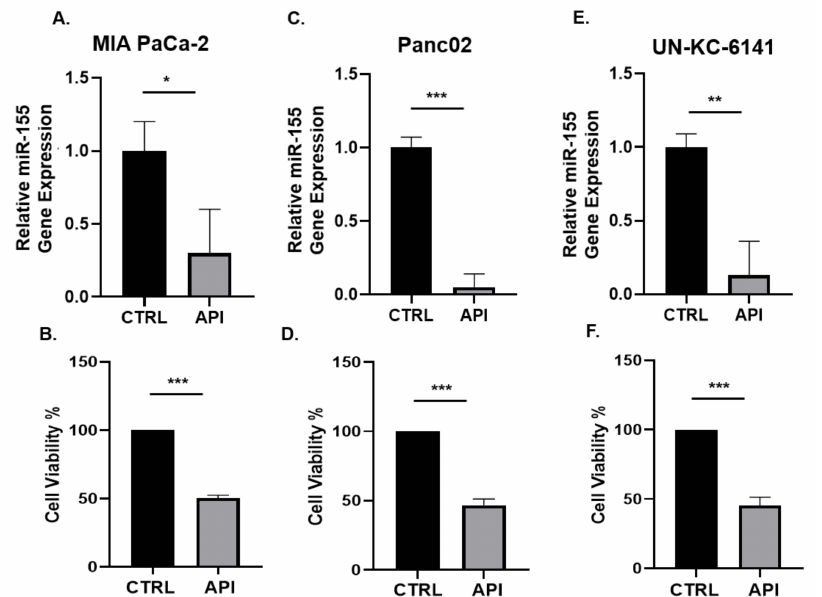
Figure 1. API suppressed miR-155 gene expression and inhibited cell viability in PC cells in vitro. The indicated human and mouse PC cell lines were treated with API (40 µ M) or vehicle (CTRL) for 24 h and assessed for ( A , C , E ) miR-155 gene expression by qPCR or ( B , D , F ) cell viability by MTT assay. Data presented as the mean ± S.D. of each experimental group ( n = 3). * p < 0.05; ** p < 0.001; *** p < 0.001 (by two-tailed t test).